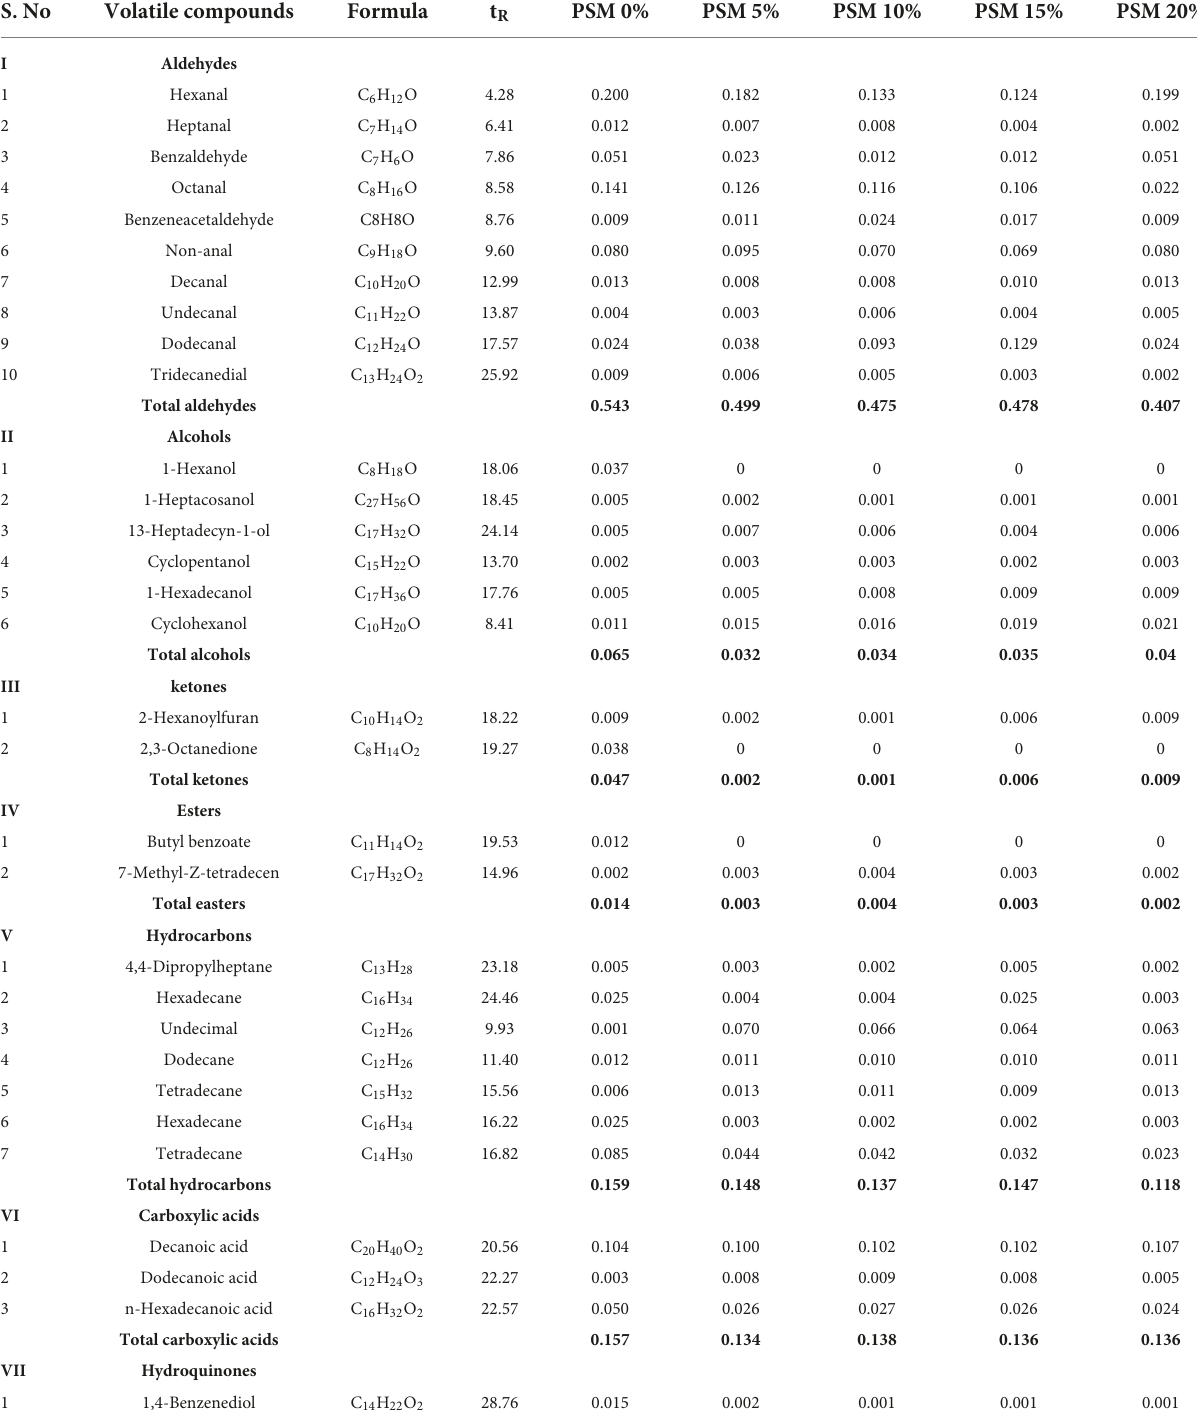
TABLE 4 Relative content a of volatile compounds in pan-fried chicken patties incorporated with different levels Perilla seed meal